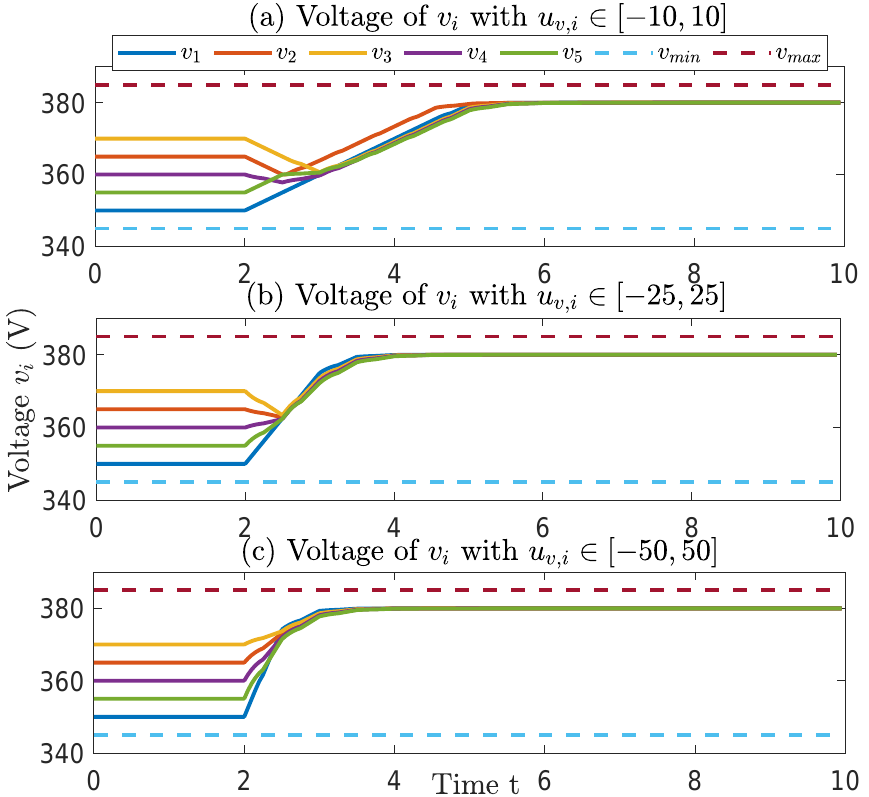
Figure 3. The voltage v i under the different states of control input: ( a ) u v , i ∈ [ − 10,10 ] ; ( b ) u v , i ∈ [ − 25,25 ] ; ( c ) u v , i ∈ [ − 50,50 ]